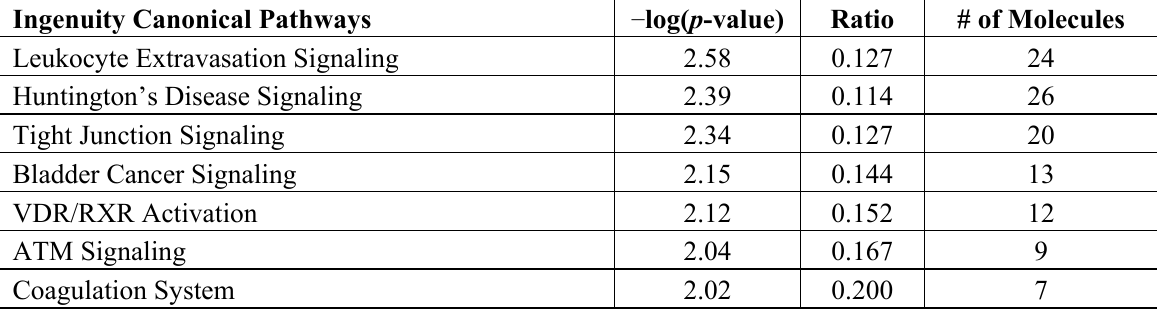
Table 2. Significant canonical pathways in 4 h post-heat exposure. 198 Ingenuity Canonical Pathways were scored at 4 h post-heat exposure; only the 19 listed pathways fit the cut-off of p -value ≤